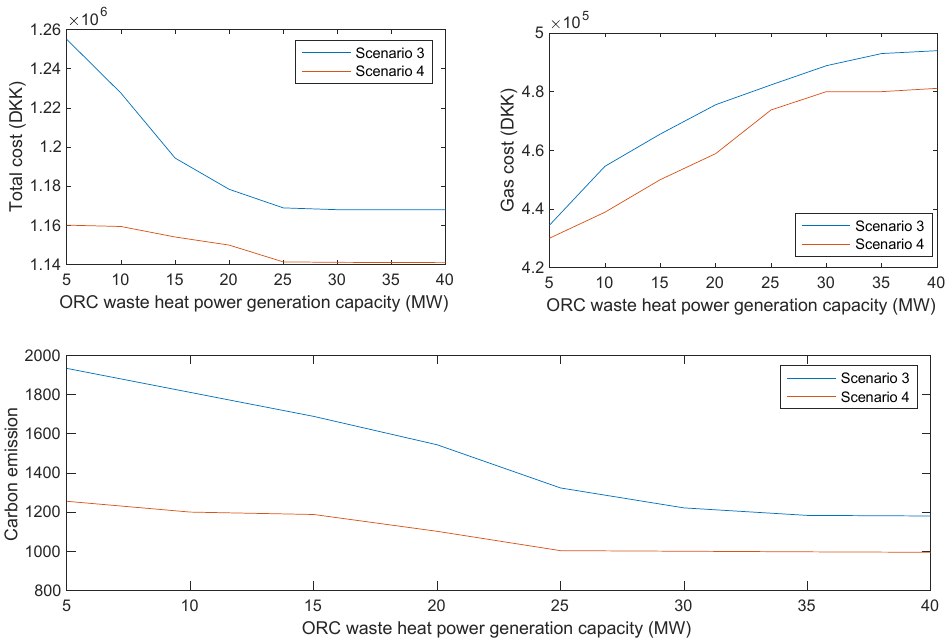
Figure 12. Sensitivity analysis of ORC capacity.